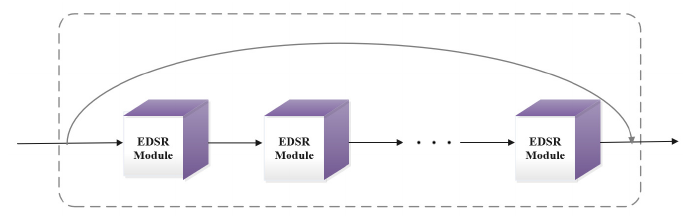
Figure 8. The architecture of the EDSR module.